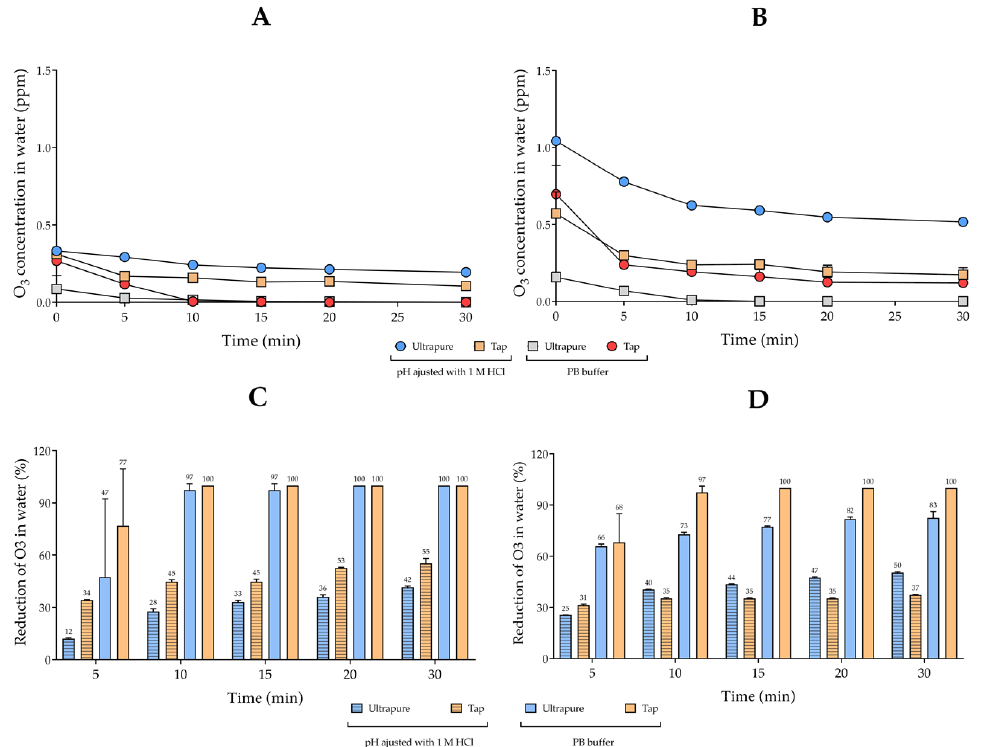
Figure 4. Comparisons of O 3 concentration and stability in ultrapure and tap waters at pH 5. Ozonation of the two types of water at 25 °C ( A ) and 4 °C ( B ). The mean with standard deviation for the concentration in parts per million (ppm) were used to calculate the percentage of O 3 reduction, considering the first sample (0 min) as the basis. The percentage values were then plotted as graphs for ( C ) 25 °C and ( D ) 4 °C. Adjustments of the pH and buffering were performed with 1 M HCl and 20 mM PB buffer, respectively.